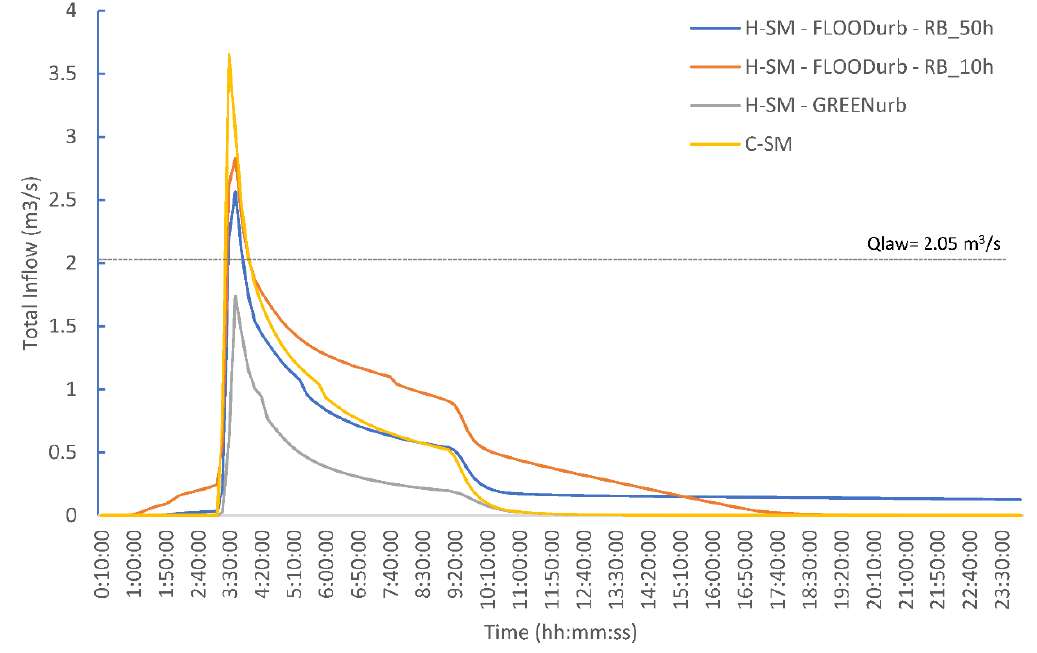
Figure 7. Hydrographs CSO 1019 under 2-year rainfall event. calculated in each CSO, are collected in Table 4. Table 4. Stormwater detention tanks volumes in the centralized scenario.